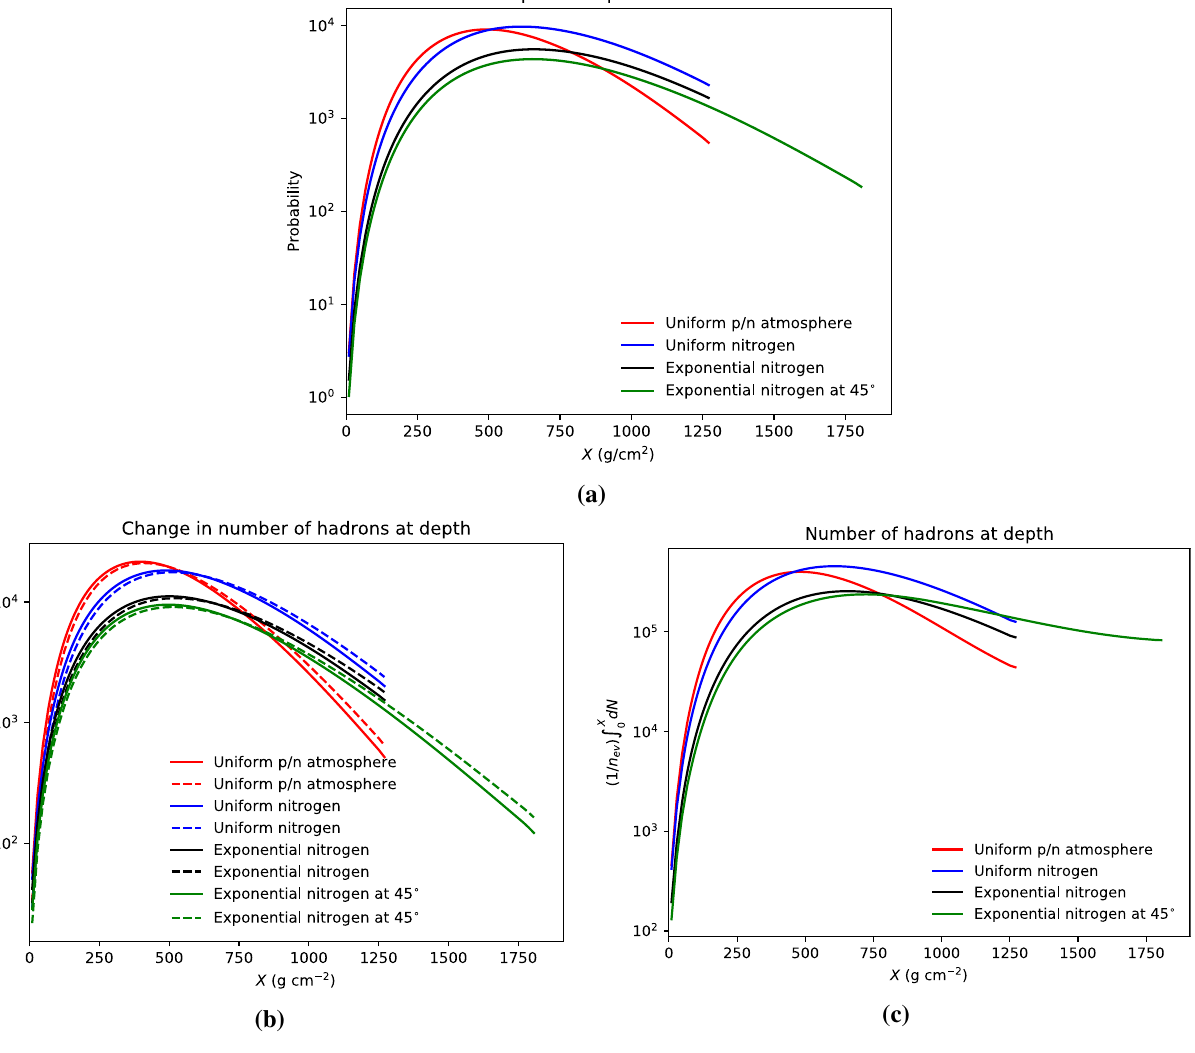
Fig. 12 Evolutionofacascadeinitiatedbya10 8 GeVprotontravelling through four different simple models of the atmosphere, as described in the text, as a function of atmospheric depth in g/cm 2 . The models stop when reaching the surface. Shown is the number of a interactions, b